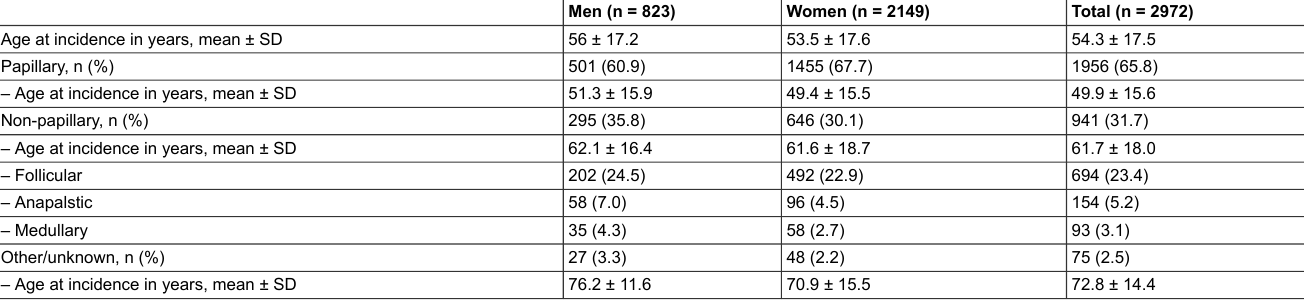
Table 1: Baseline characteristics of the study population.